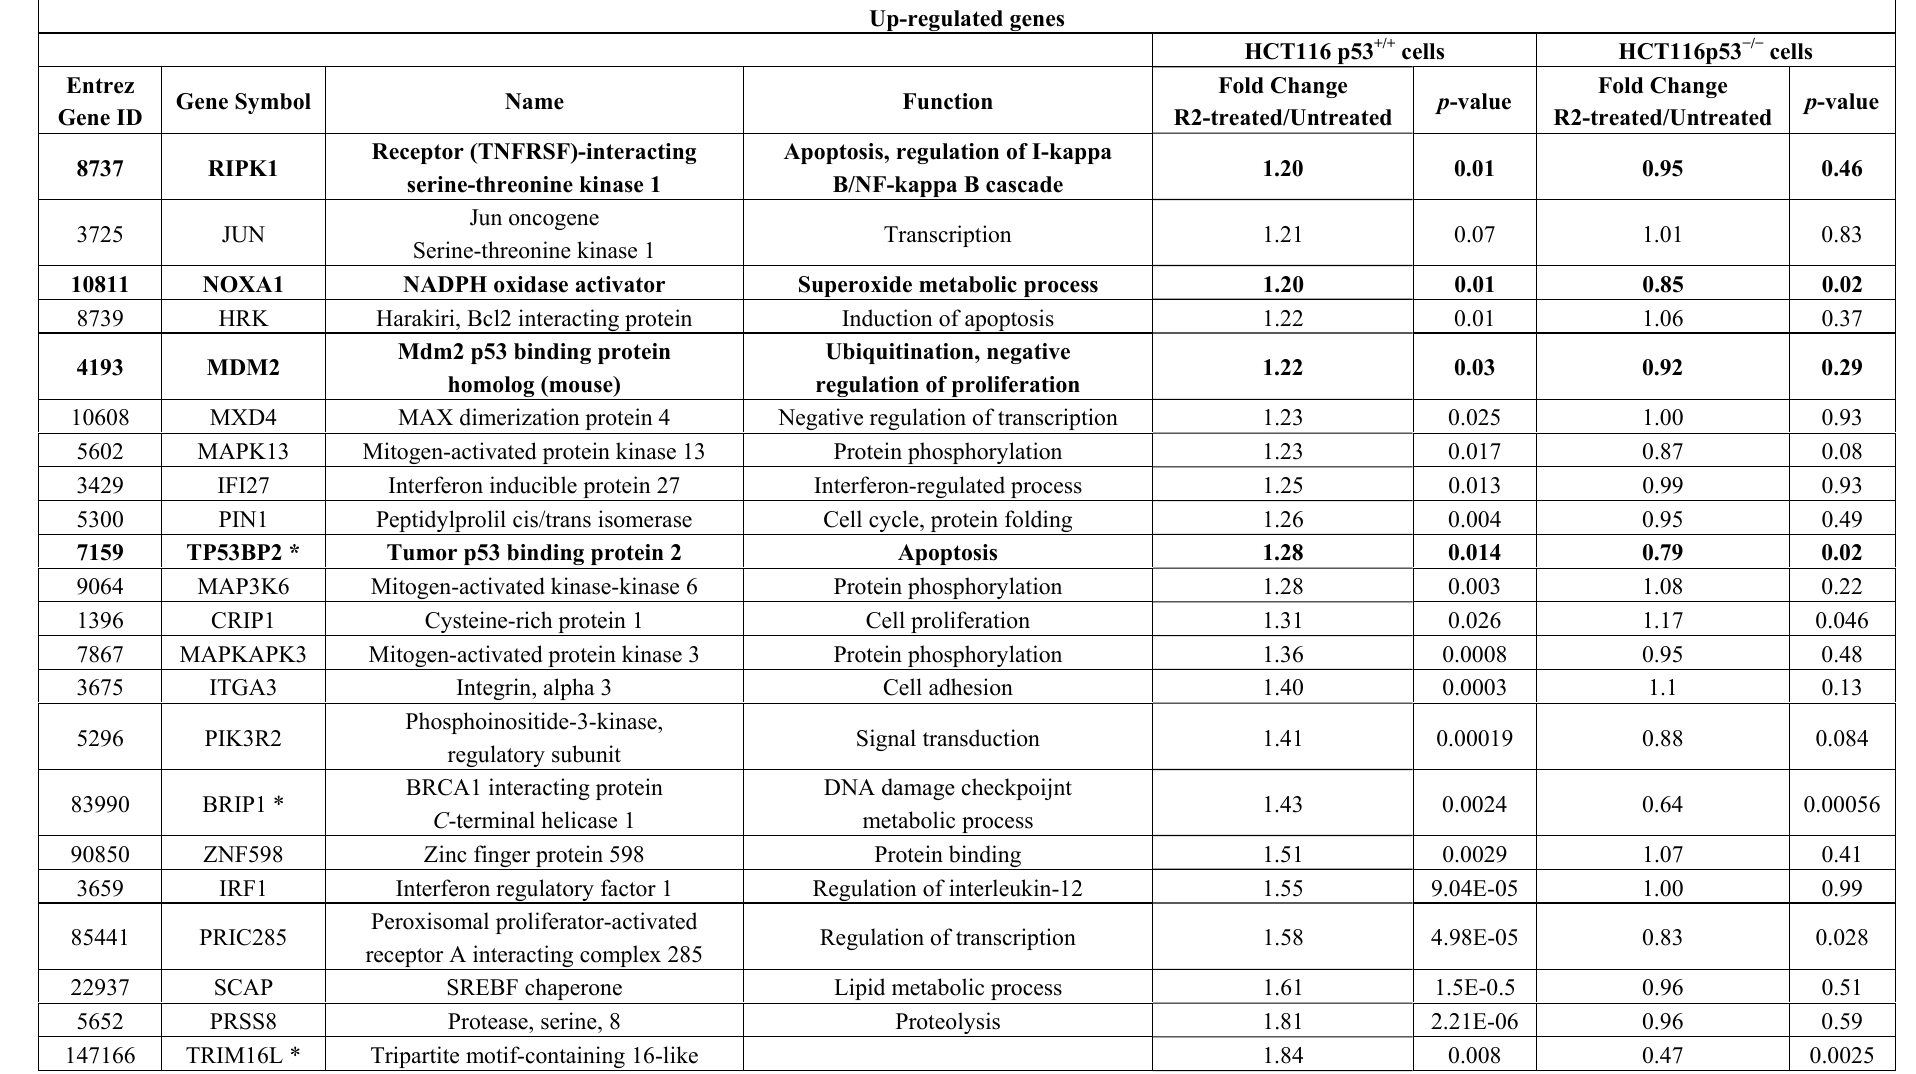
Table 1. Several up-regulated and down-regulated genes by 25 μ M R2 in HCT116 p53 +/+ cells in a p53-dependent manner ( ≥ 1.2-fold, p < 0.05).